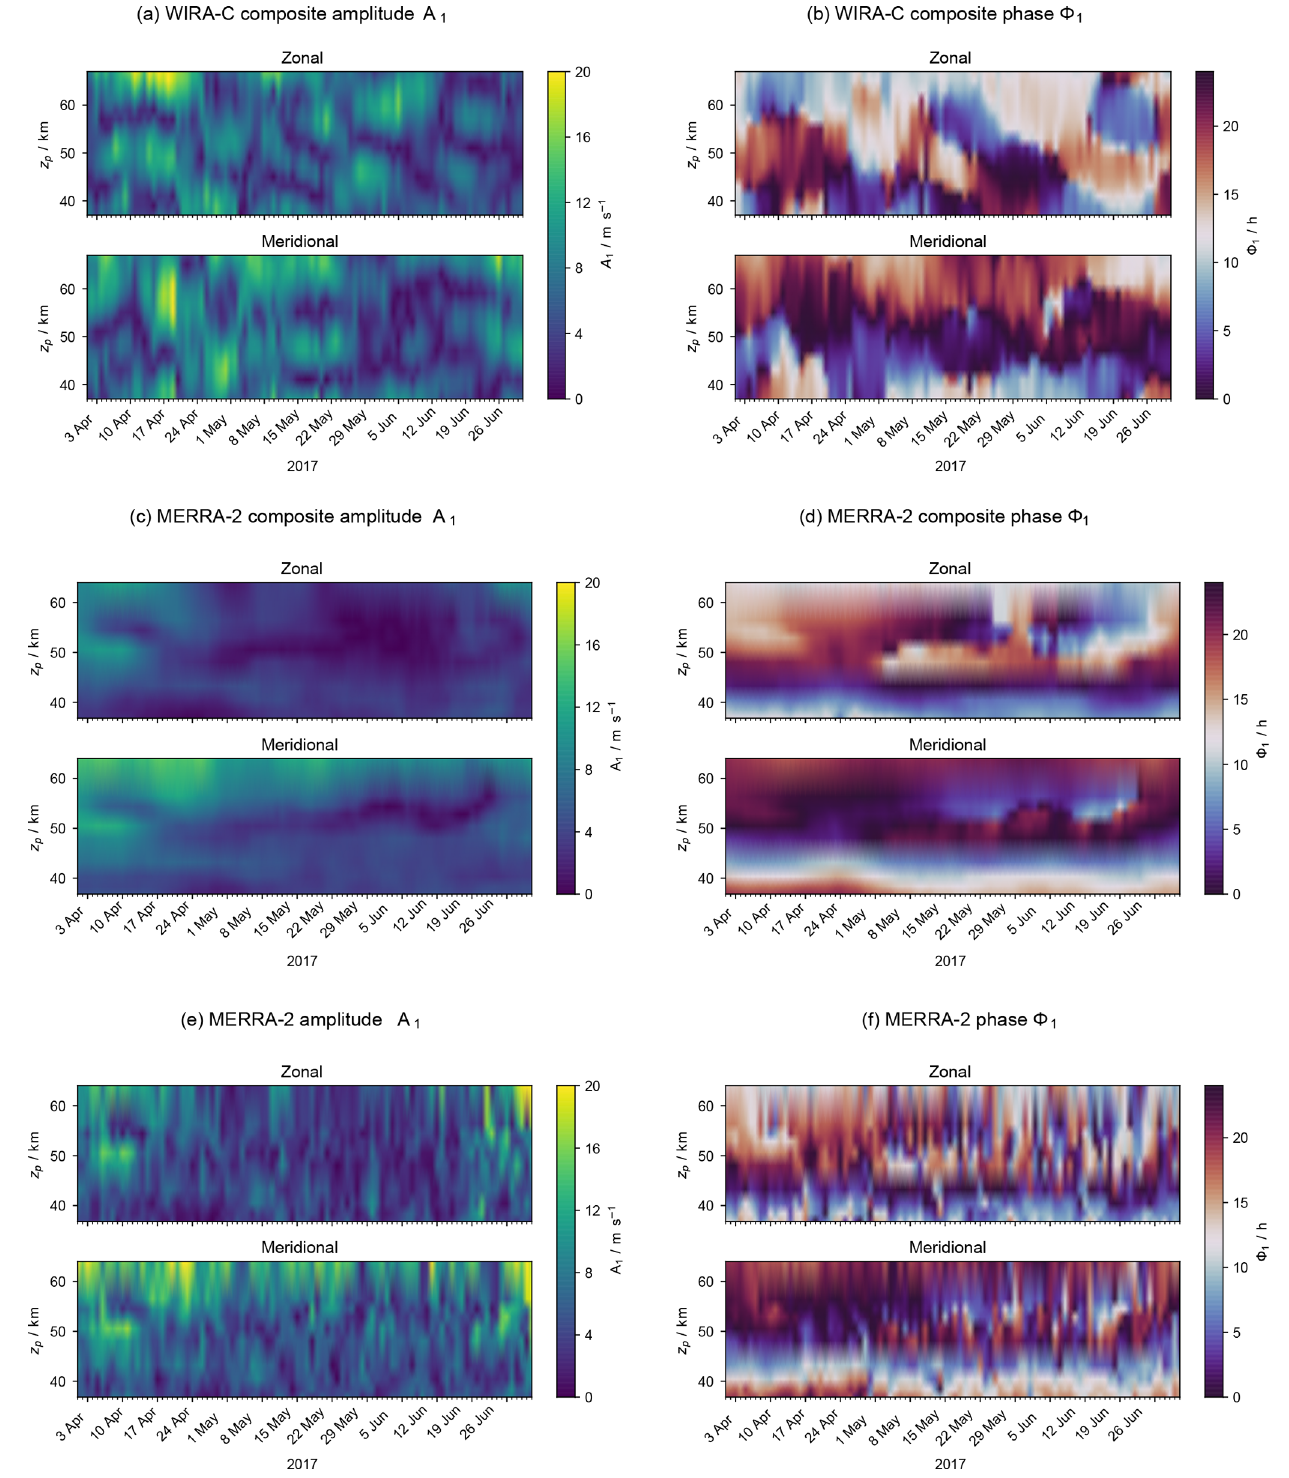
Figure 5. Amplitude and phase of the diurnal tide over 3 months from WIRA-C measurements (a, b) , smoothed MERRA-2 reanalysis (c, d) , and original MERRA-2 (e, f) during the tropical campaign at the Maïdo